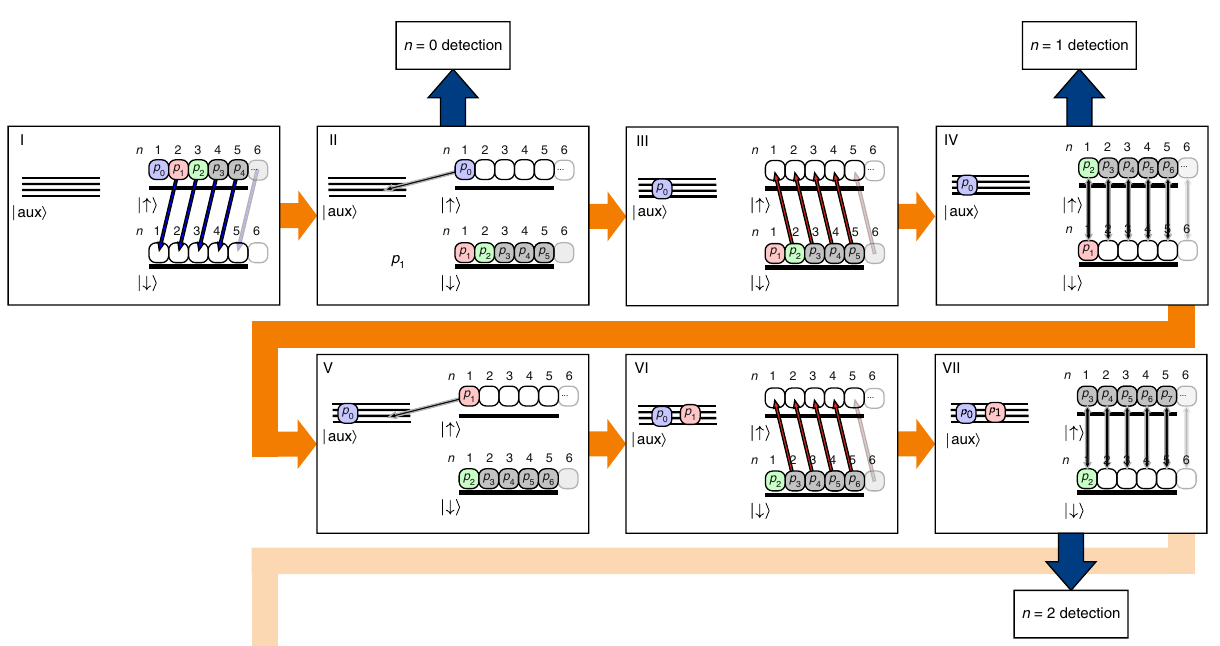
Fig. 5 Experimental scheme to measure the motional state overlap with Fock state n . The reduced level scheme shows the spin states | ↓ 〉 , | ↑ 〉 and the manifold of auxiliary states |aux 〉 (see text for details). The boxes indicate the current motional state within the sequence. The values p n denote the initial population of the Fock state n . The sequence starts with the ion in the | ↑ 〉 state and an unknown motional state distribution.(I) A blue sideband RAP pulse fl ips the spin and removes a phonon from all excited Fock states, leaving the ground state population untouched. (II) The motional ground state population is measured via spin state-selective fl uorescence. To detect the population of higher order Fock states, the ground state population is hidden by a sequence of rf-pulses in one of the auxiliary states |aux 〉 1 . (III) A red sideband RAP pulse fl ips the spin and removes a phonon from all excited Fock states | ↓ 〉 . Therefore only the population that was initially in the n = 1 Fock state remains in the bright spin state. (IV) Detection of the ions spin gives the n = 1 Fock state population. Alternatively, step (II) – (IV) can be repeated after a rf carrier π - fl op to detect higher order Fock states (see (V) – (VII)). However, only a single selected Fock state population can be measured in a single